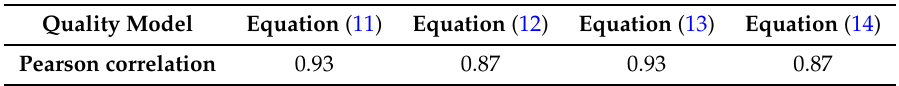
Table 5. Values of the Pearson correlation between the MOS V values and the quality models defined in Equations (11)–(14) with regard to the analog data